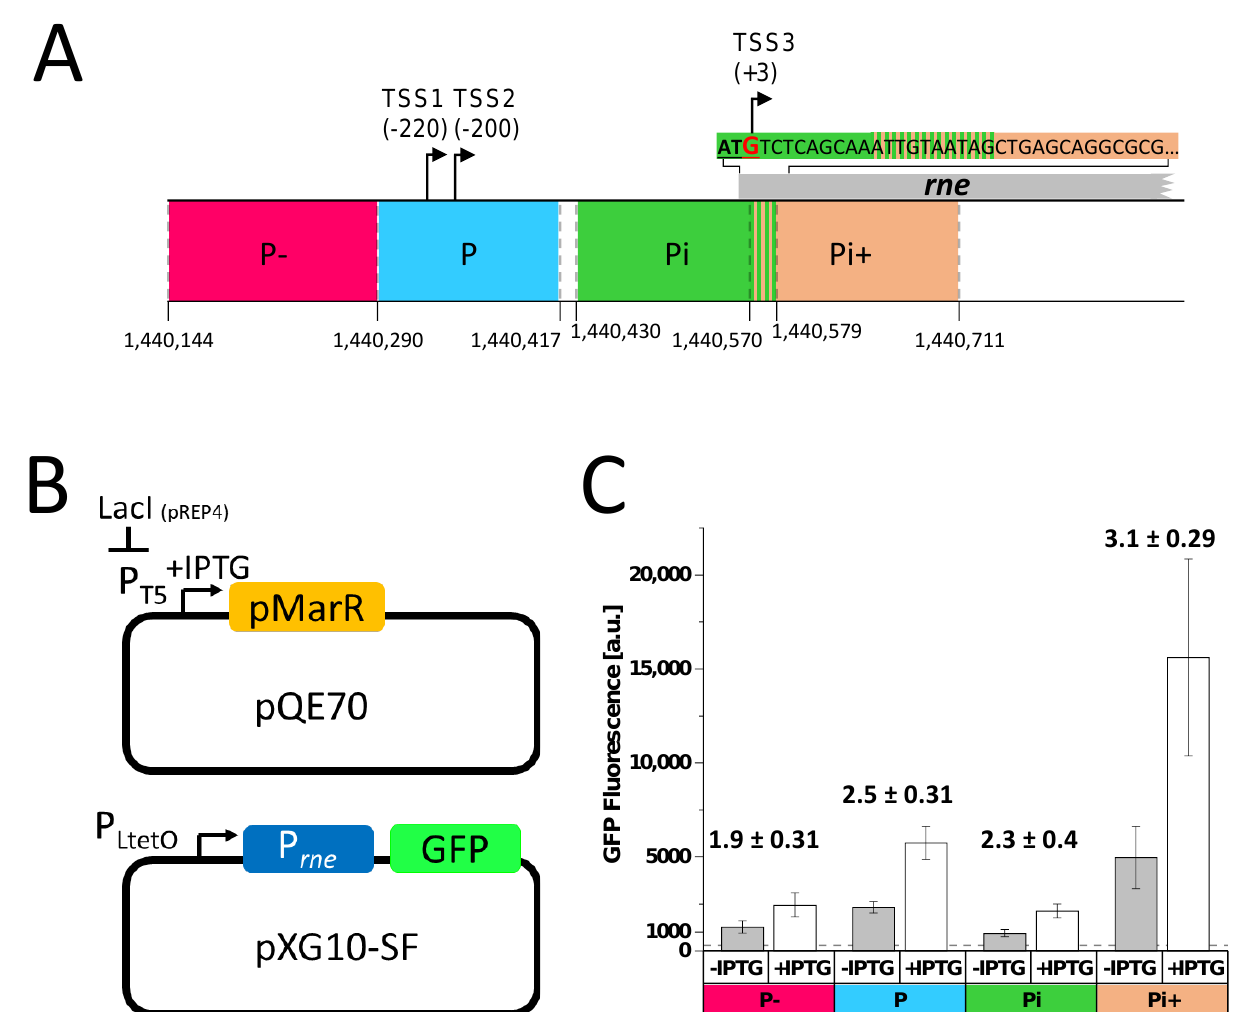
Figure 1. Influence of pMarR transcriptional regulator PSSP7_011 on MED4 rne promoter